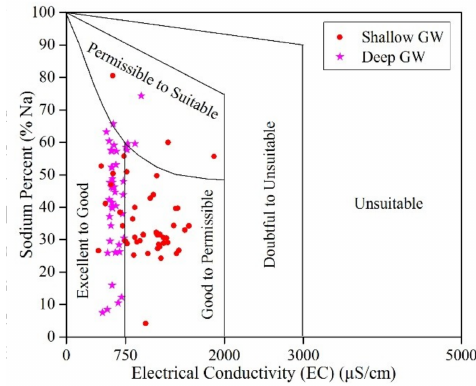
Figure 12. Wilcox diagram (%Na vs. EC) for assessing Irrigation water